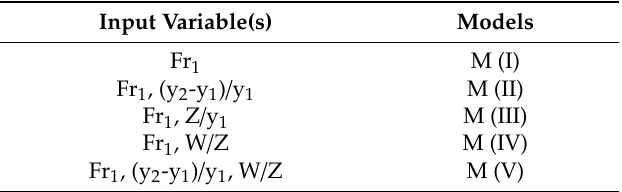
Table 2. Kernel Extreme Learning Machine (KELM)-developed